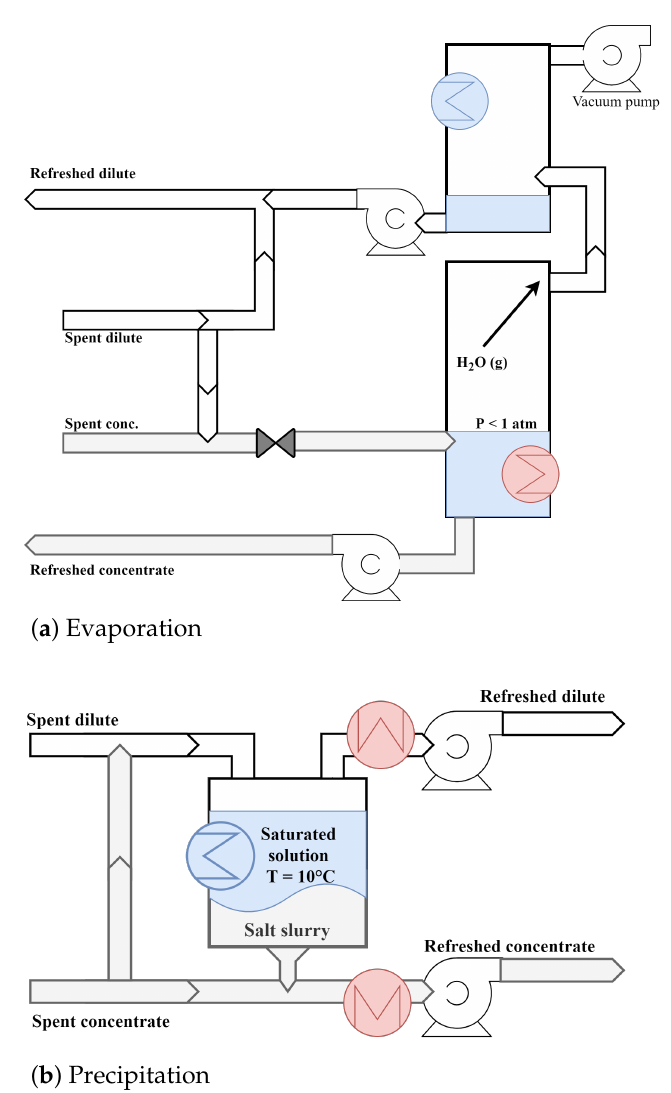
Figure 3. Schematic description of a thermal solution regeneration by ( a ) evaporation and ( b ) precipitation. A red heat exchanger depicts heat added to the system, whereas a blue heat exchanger marks heat withdrawn.